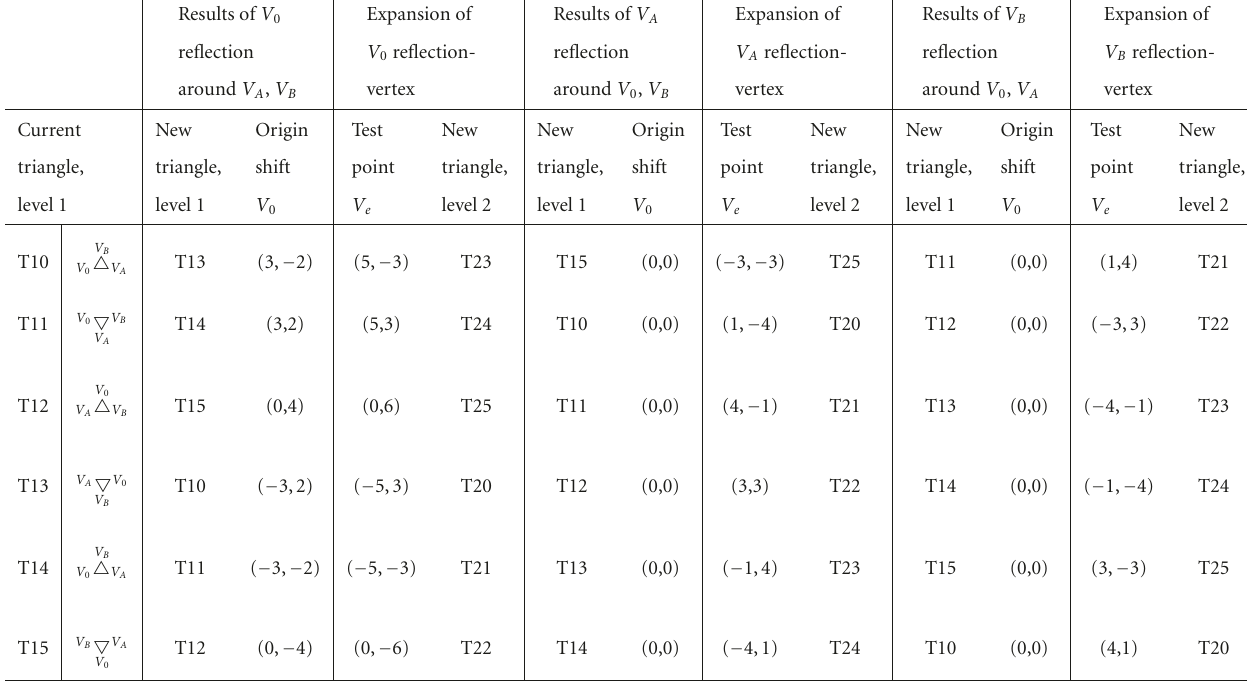
Table A.1: Possible reflections and expansions of level 1 triangles.